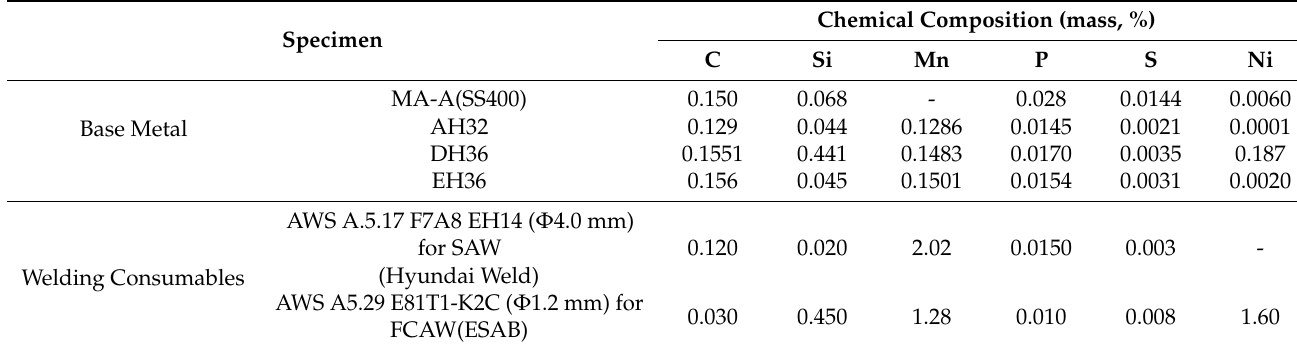
Table 1. Chemical compositions of specimen.